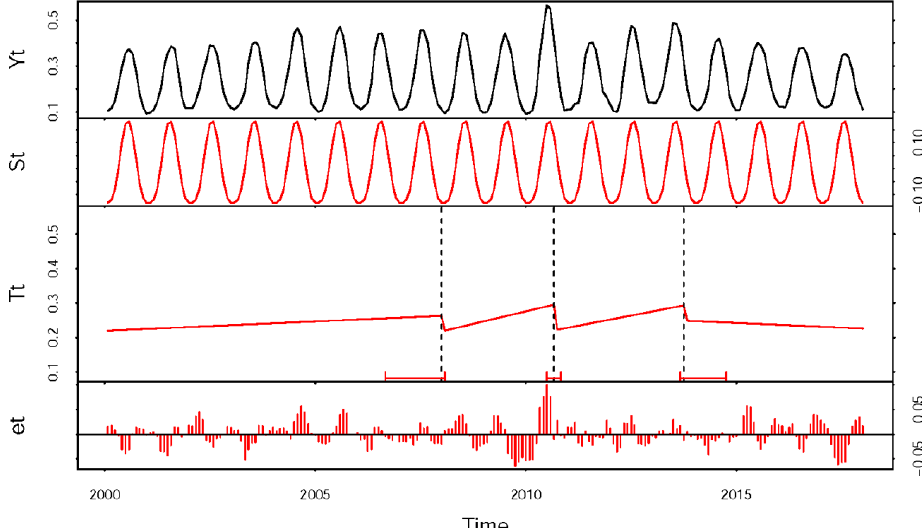
Figure 3. The seasonal, trend and remainder components of a MODIS NDVI time series over a grassland pixel (Lat. 38°49 ′ N, Lon. 98°25 ′ E) from 2000 to 2017 that were decomposed using the BFAST procedure. Yt is the original NDVI data, St, Tt and et stand for decomposed seasonal, trend